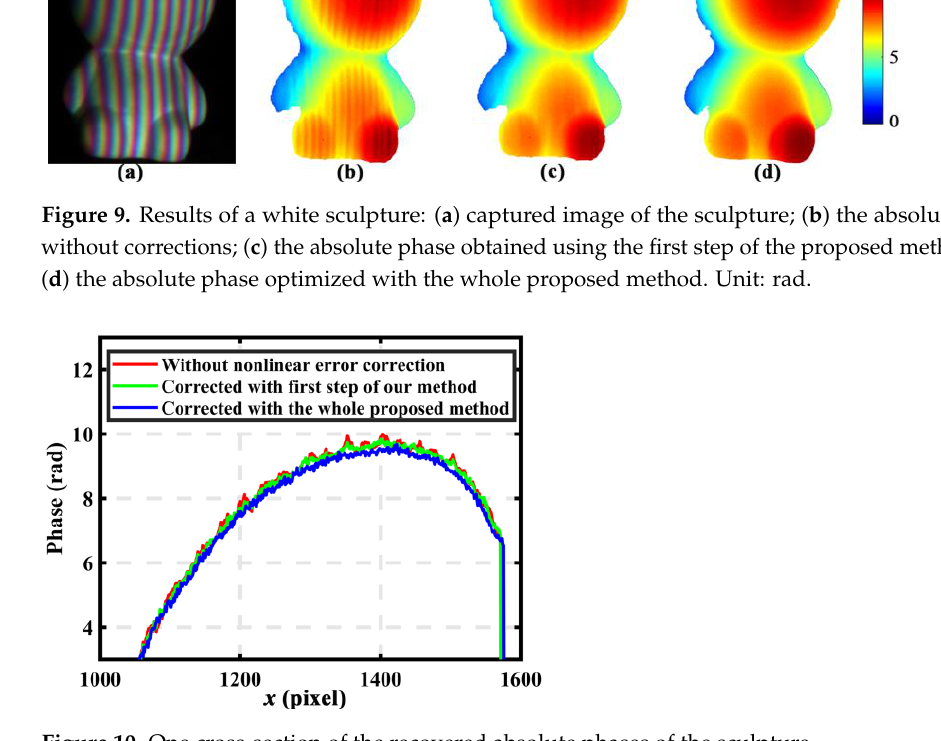
Figure 11. Results of a white fish: ( a ) captured image of the fish; ( b ) the absolute phase without corrections; and ( c ) the absolute phase obtained the proposed method. Unit: rad.